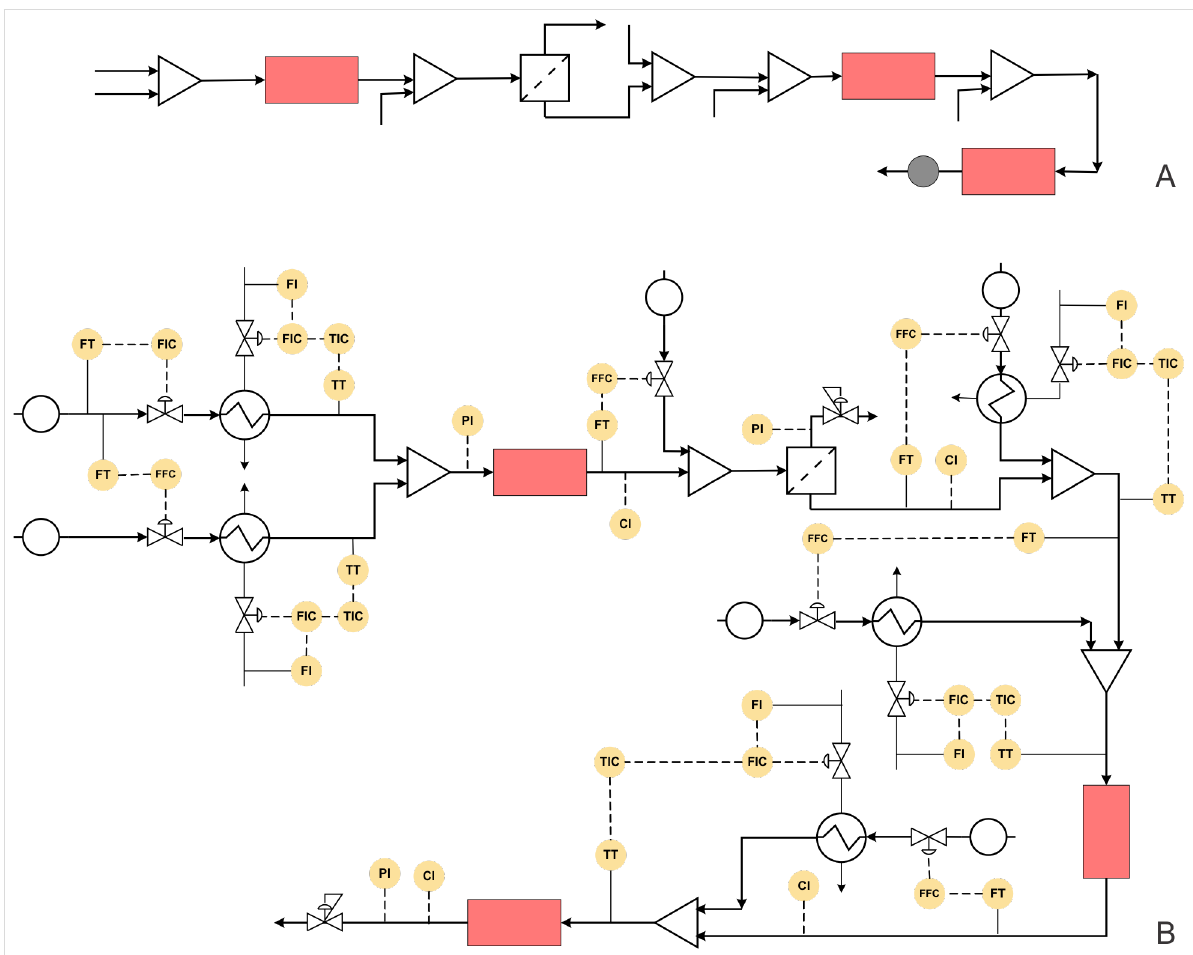
Figure 7: (A) Block diagram representation of the process shown in Scheme 5, (B) piping and instrumentation diagram of Scheme 5.